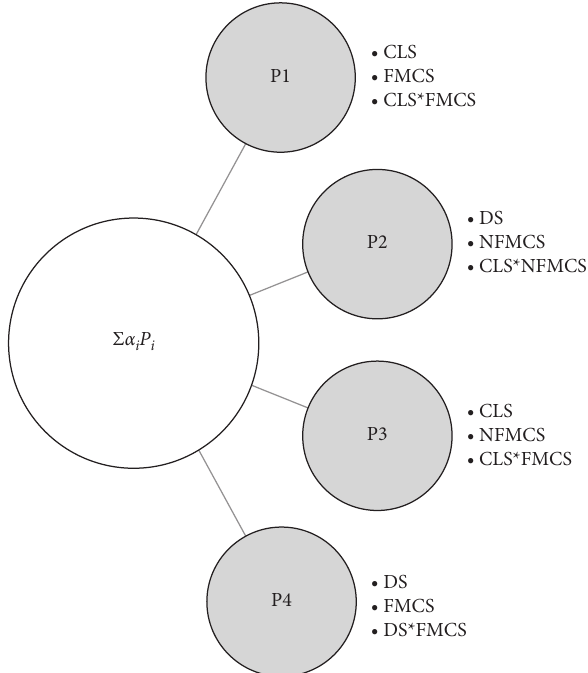
Figure 3: The primary equation system of the